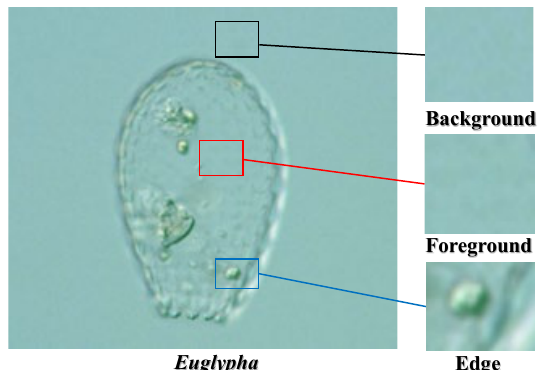
Figure 1. An example of transparent images (a low contrast environmental microorganism